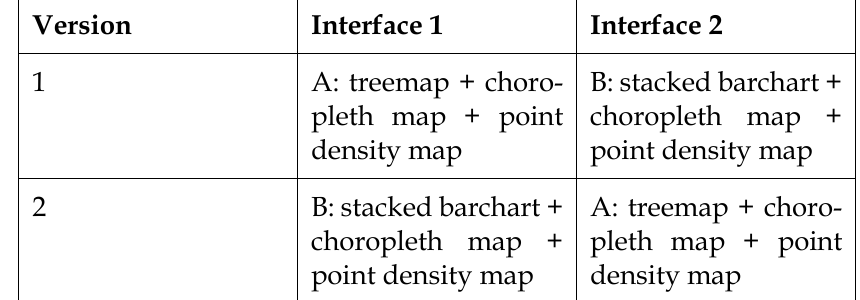
Table 1: 2x2 Latin square for interface order by